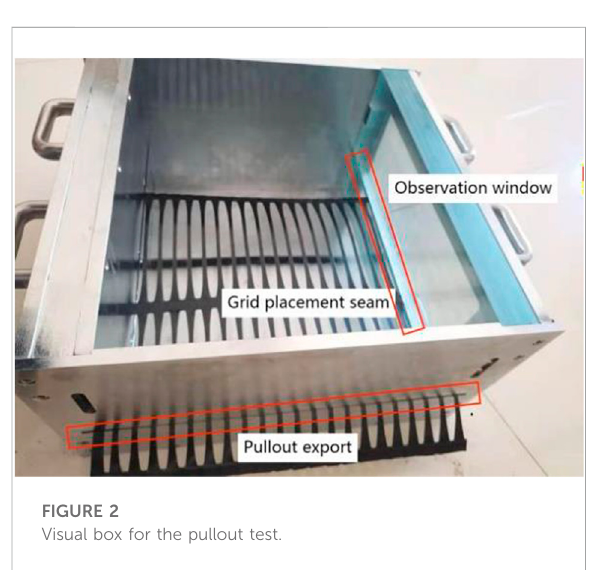
FIGURE 2 Visual box for the pullout